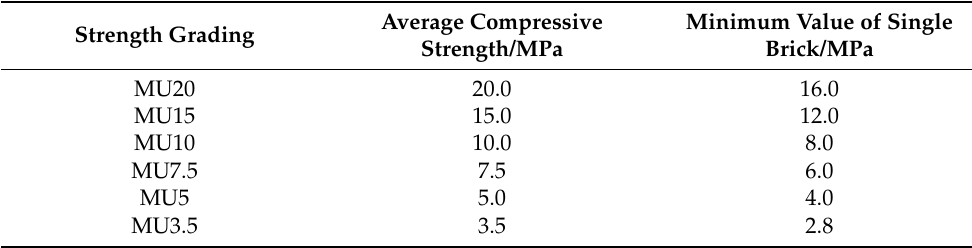
Table 4. Grading of recycled aggregate pavement bricks.